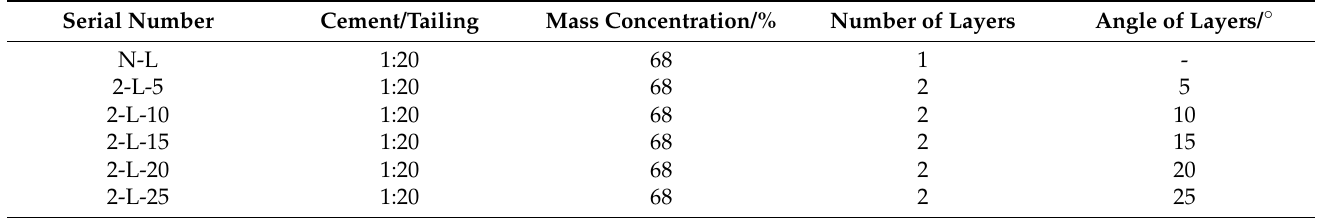
Table 2. Summary of the test plan.